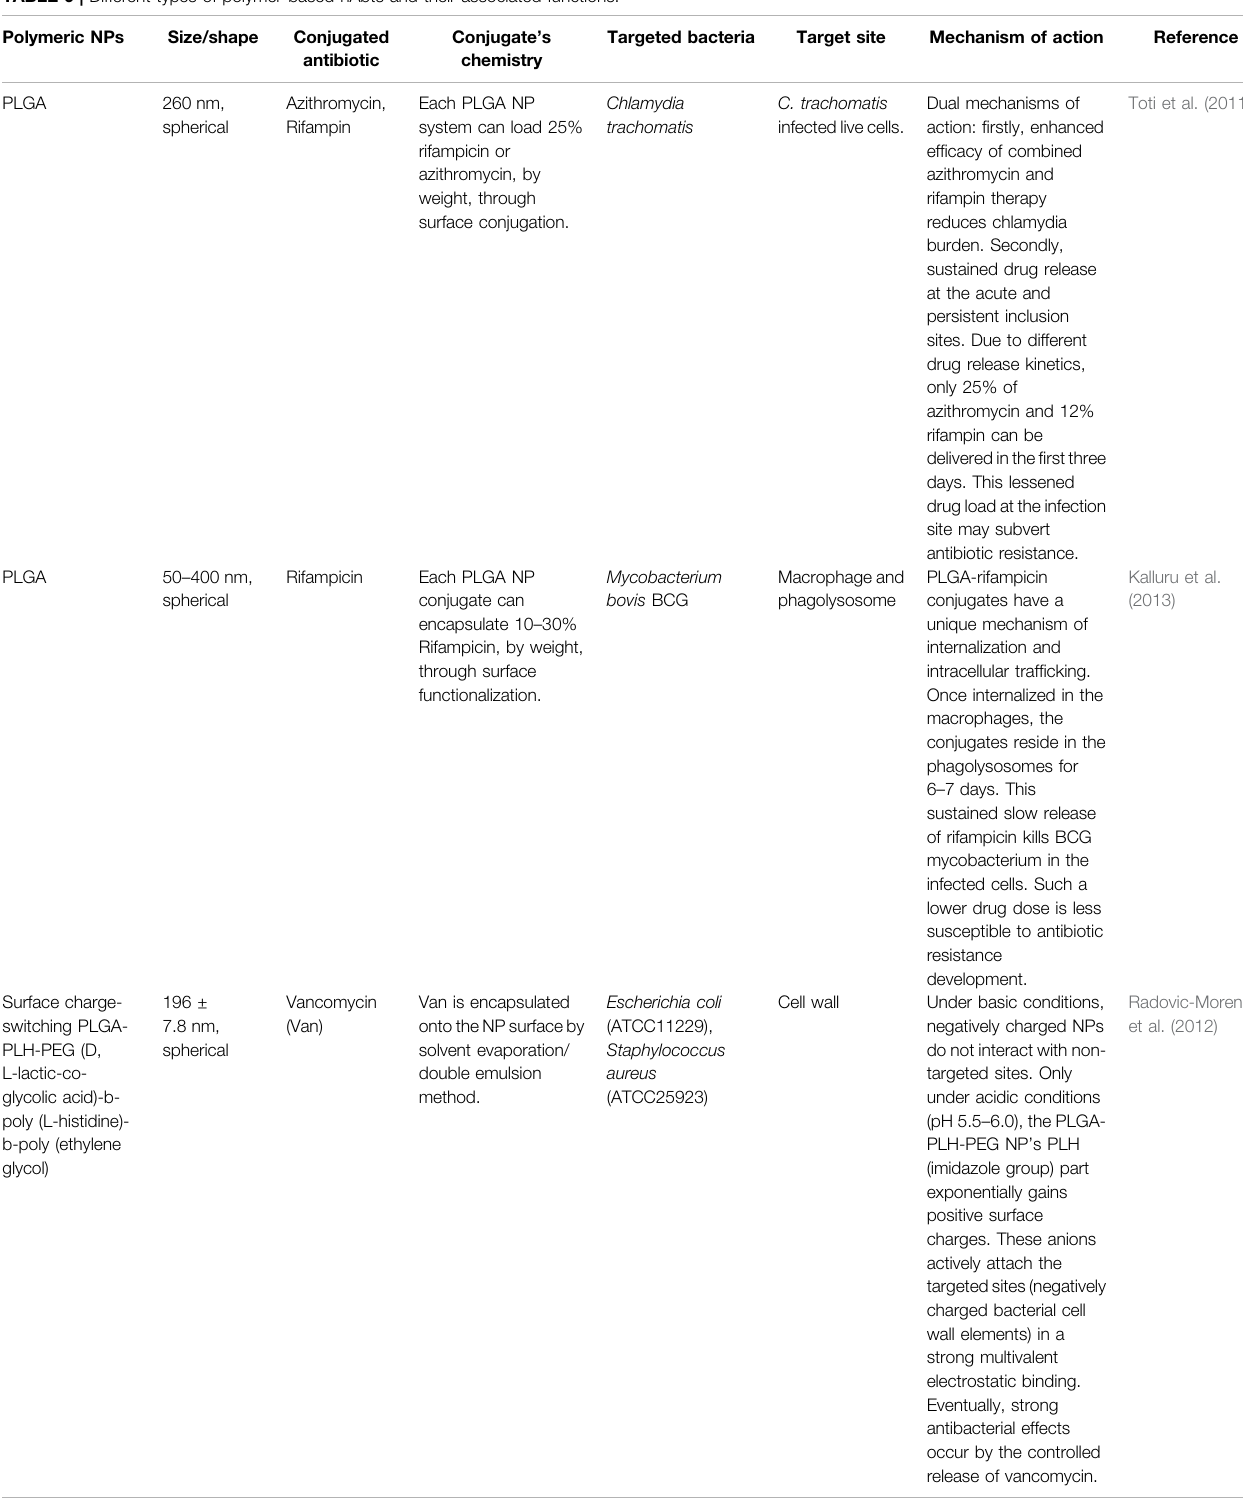
TABLE 6 | Different types of polymer-based nAbts and their associated